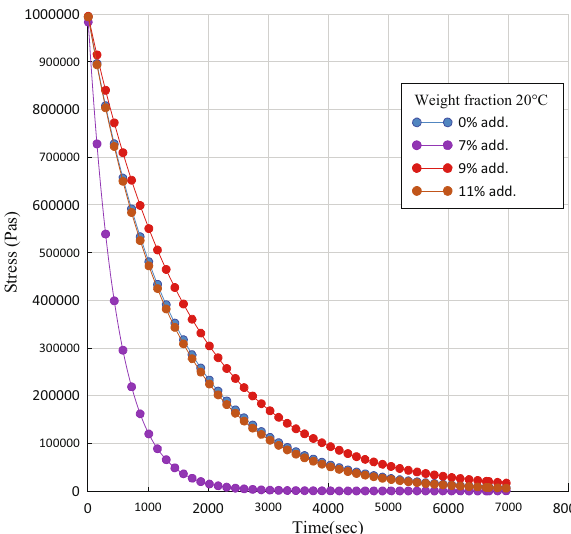
Figure 8: Modulus of elasticity for UP/PS reinforced with fi sh fl akes for di ff erent weight fractions at